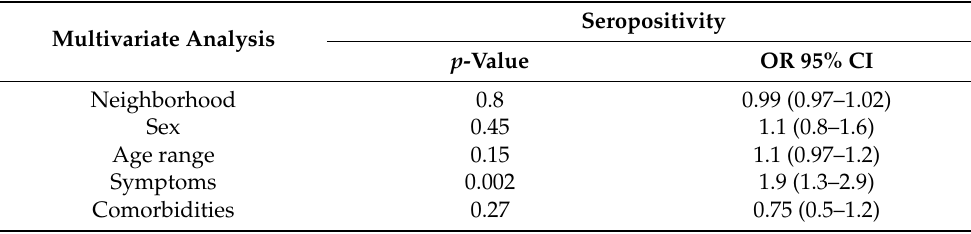
Table 4. Multivariate analysis among the cluster of variables evaluated with the probability of being seropositive for